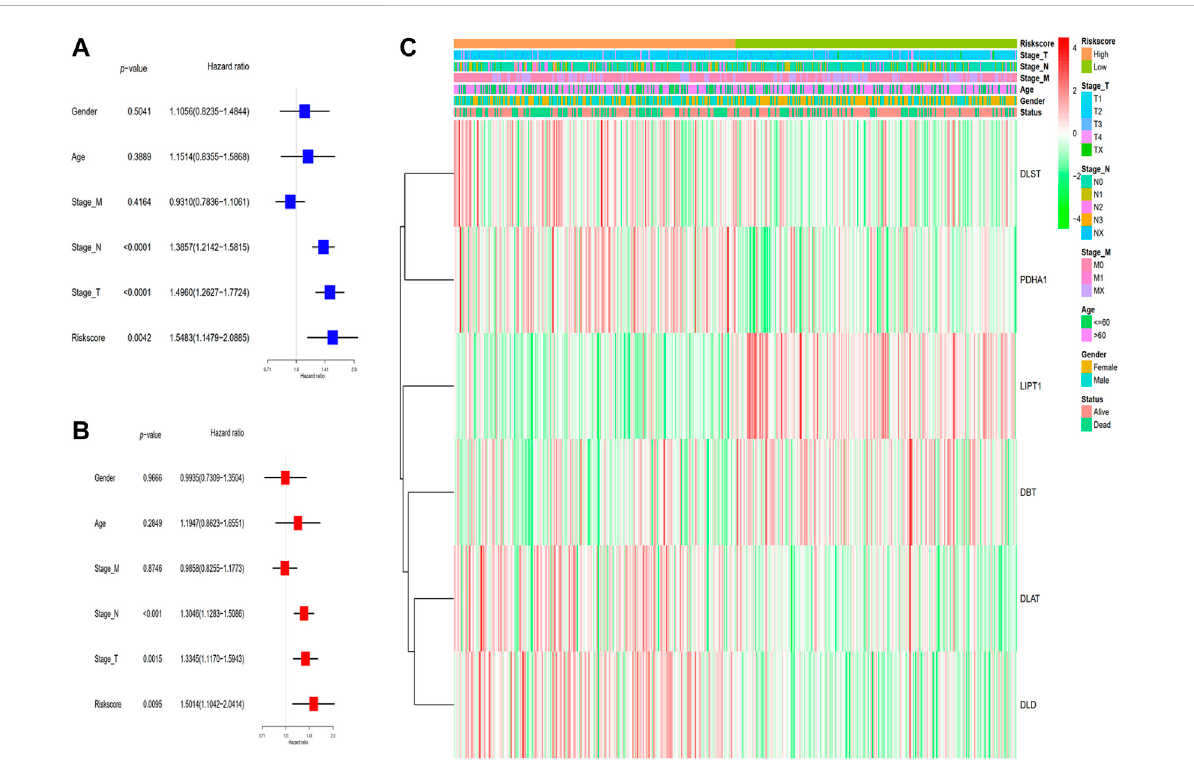
FIGURE 4 Analyses of the risk score utilizing univariate and multivariate Cox regression. (A) The TCGA dataset was subjected to a univariate analysis. (B) TheTCGAcohortwassubjected toamultivariate analysis. (C) Heatmapdepicting theassociationsbetween clinicalandpathological parameters and risk groups.